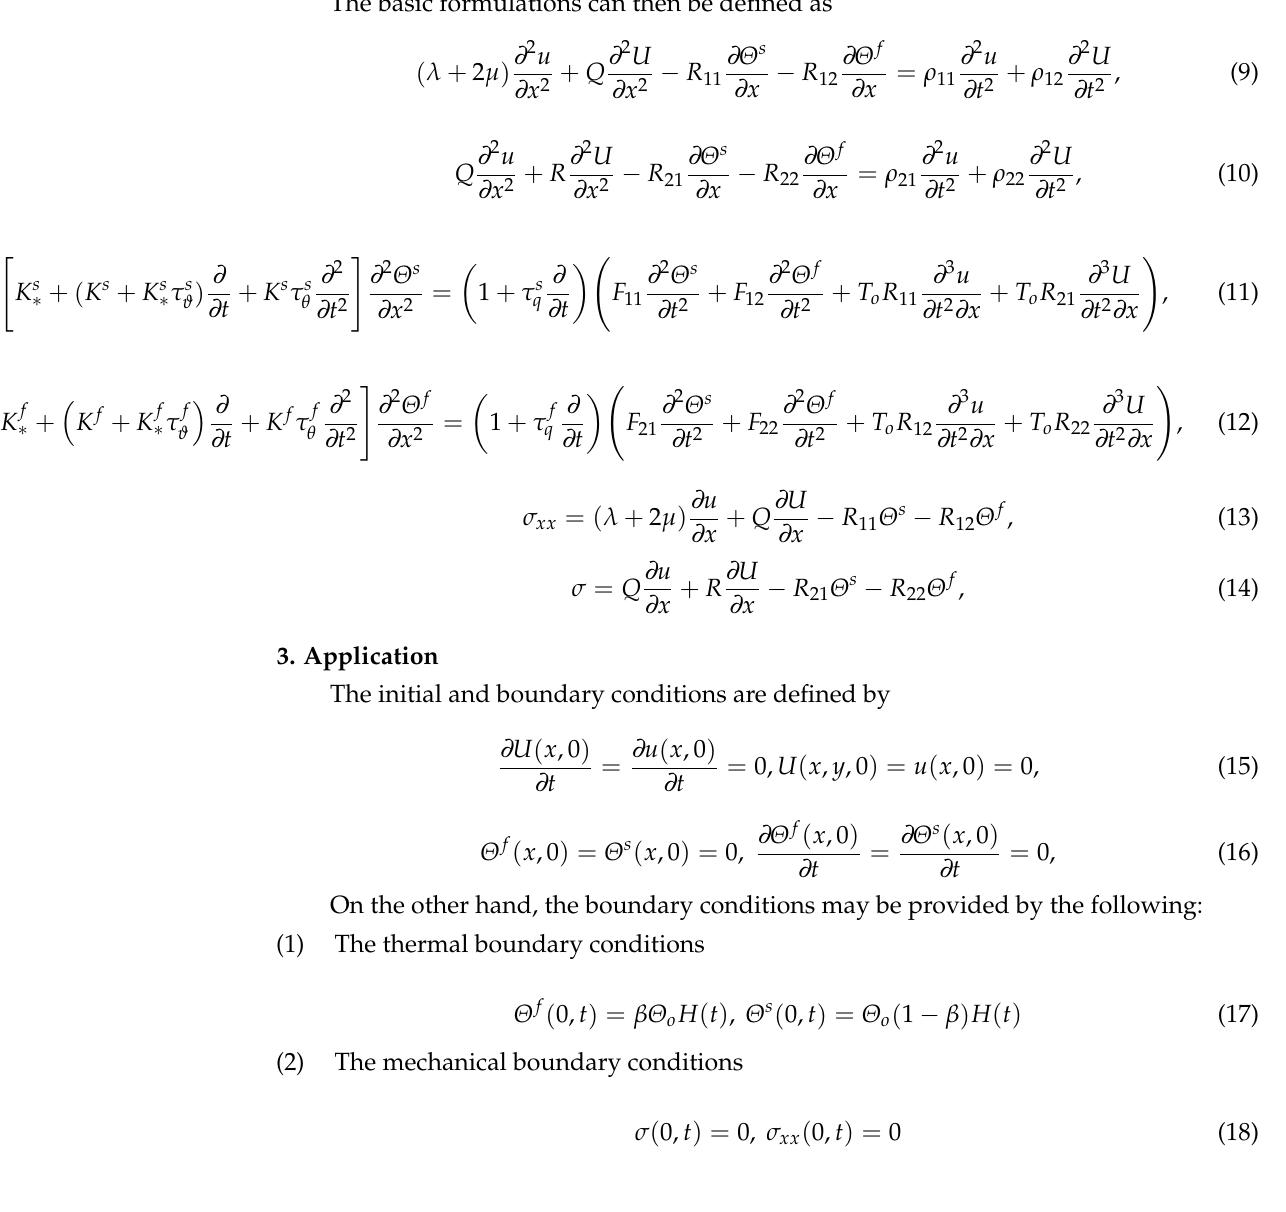
Figure 1. Diagram of the